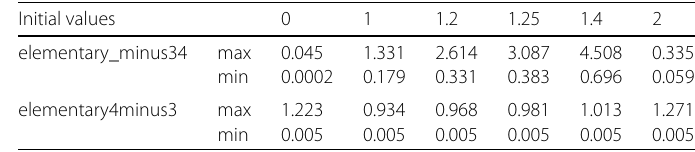
Table 6 Largest and smallest Euler